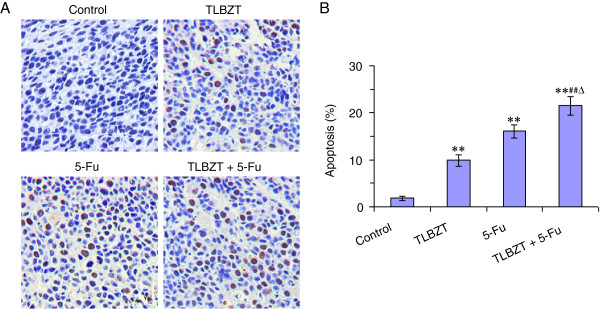
TLBZT and 5-FU induced apoptosis in CT26 carcinoma. After three weeks treatment, CT26 carcinomas were collected and subjected to TUNEL assay (3 tumors/group) and observed under microscope (×200) (A). The apoptotic cells were counted in 3 high power fields (HPF) in each slide. The percentage of apoptosis cells were expressed as means ± SD (B). **P<0.01, versus control group. ##P<0.01, versus TLBZT group, ΔP<0.05, versus 5-Fu group.